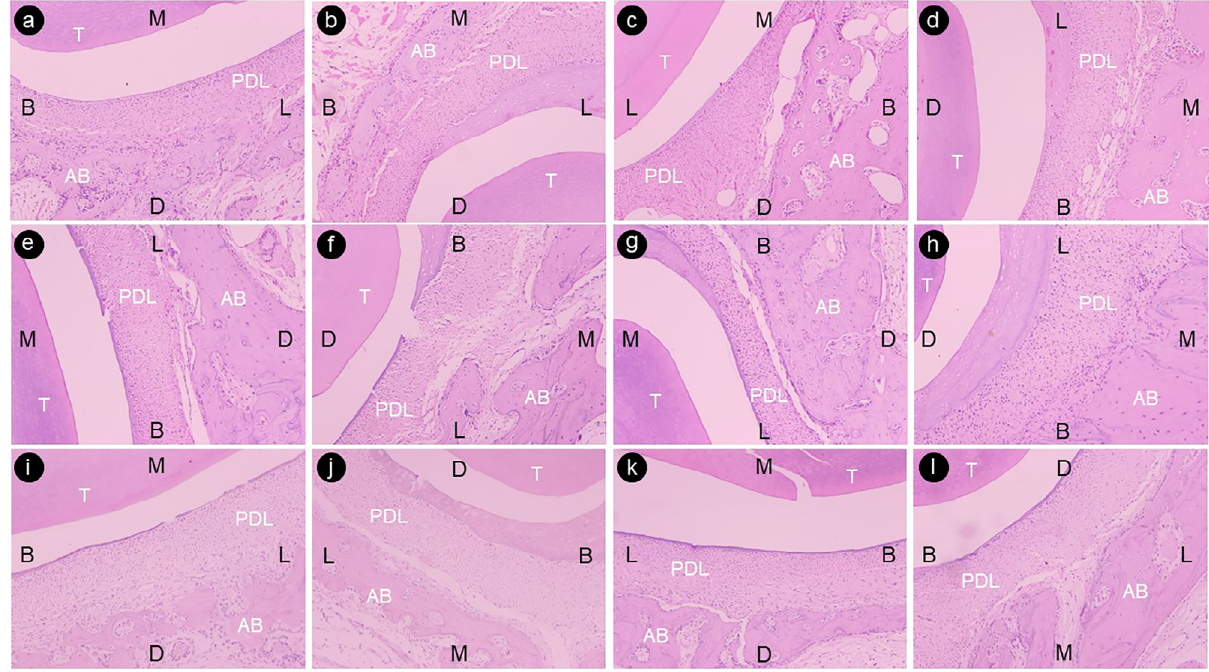
Figure 3- Microphotograph of the distal periodontal tissues of the first premolar with H&E staining (×40). a, the tension area, the control side, Group A; b, the compression area, the control side, Group A; c, the tension area, the surgical side, Group A; d, the compression area, the surgical side, Group A. e, the tension area, the control side, Group B; f, the compression area, the control side, Group B; g, the tension area, the surgical side, Group B; h, the compression area, the surgical side, Group B. i, the tension area, the control side, Group C; j, the compression area, the control side, Group C; k, the tension area, the surgical side, Group C; I, the compression area, the surgical side, Group C. T, tooth; PDL, periodontal ligament; AB, alveolar bone. B, buccal; D, distal; L, lingual; M,